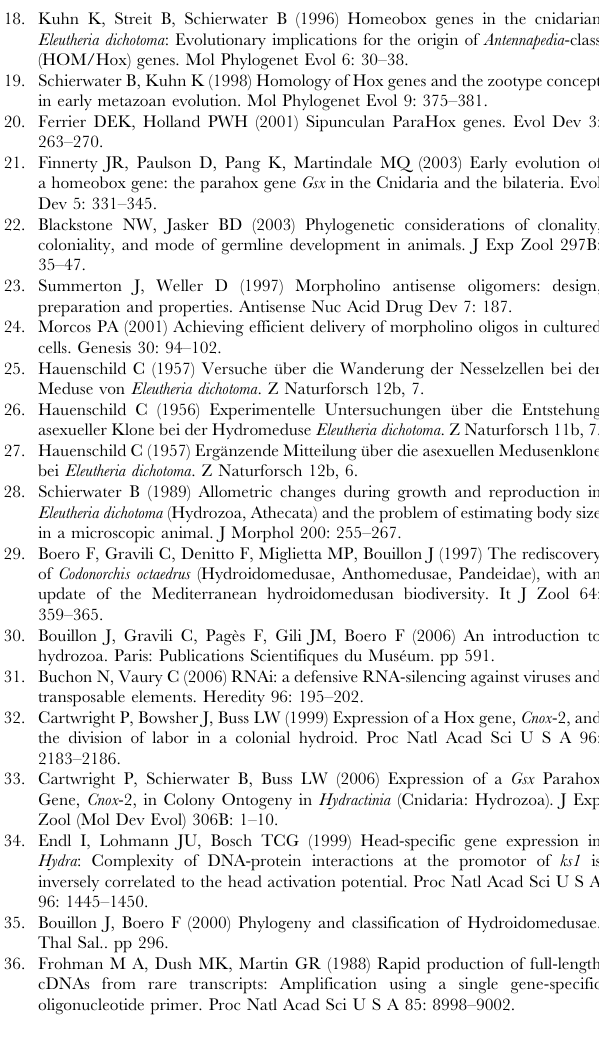
Figure S3 RT-PCR of all five Hox-like genes in Eleutheria dichotoma. Differential expression of Cnox -1 to Cnox -5 gene in Eleutheria dichotoma medusae. Shown are products of RT-PCR after 27 cycles of Cnox -1 (lane 1; 401bp), Cnox -2 (lane 2; 426bp), Cnox -3 (lane 3; 241bp), Cnox -4 (lane 4; 199bp), Cnox -5 (lane 5; 219bp) and Eleutheria -actin (lane 6; 152bp). Cnox -4 and Cnox -5 are only weakly expressed. Found at: doi:10.1371/journal.pone.0000694.s003 (0.10 MB PDF) Figure S4 RT-PCR of Cnox -1-Ed after gene knock down. Transfection with dsRNA significantly reduces Cnox gene expression. RT-PCR products from untreated control animals are shown in lanes 1 and 2, from control dsRNA animals in lanes 3 and 4, and from Cnox -1 dsRNA-infected animals in lanes 5 and 6. Products in lanes 1, 3, and 5 are actin controls. Note the strong decline of Cnox product in lane 6 relative to lanes 2 and 4. Shown here is the example for Cnox -1 in Eleutheria dichotoma ; RT-PCR controls look similar for all five Hox-like genes (data not shown). RT-PCR controls were taken as subsets from the transfected animals used in the gene silencing studies. Found at: doi:10.1371/journal.pone.0000694.s004 (0.10 MB